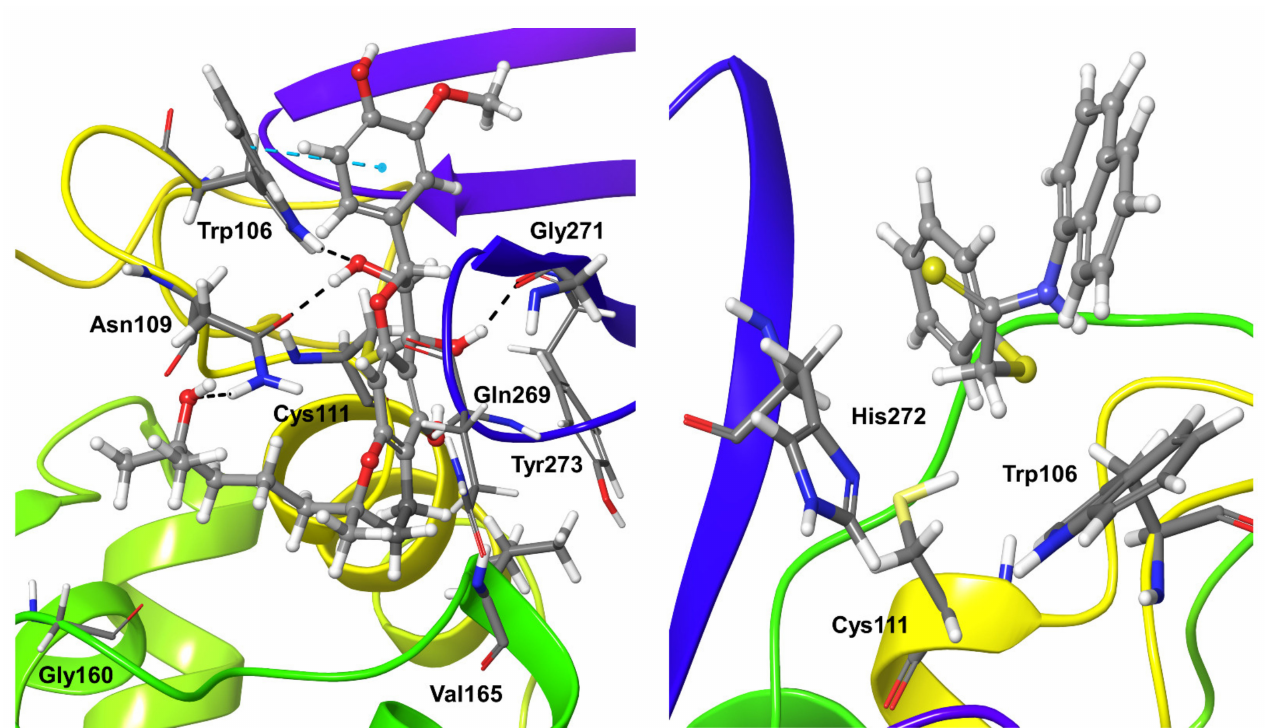
Figure 6. Stable interactions observed during MD refinement of top binding poses of compound 5 ( left ) and 6 ( right ) with SARS-CoV-2 Plpro. The inhibitors are shown in ball and stick representation, stable and moderately stable ligand-protein interactions are represented as thick tubes, short time interactions (less than 30%) are represented as thin